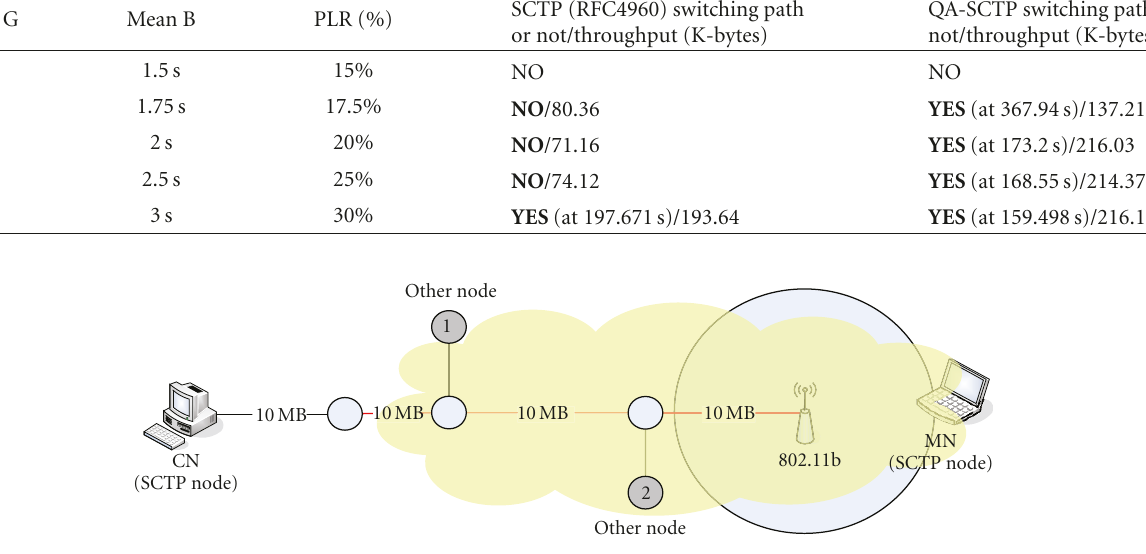
Figure 10: Impact of network condition on transmission e ffi ciency of experimental